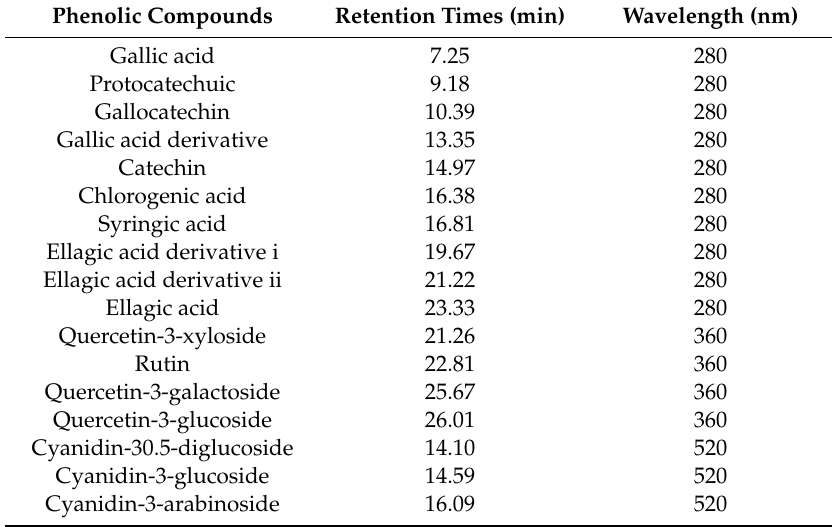
Table 6. Retention time and wavelength of phenolic compounds at Lambda 280 nm, Lambda 360 nm, and Lambda 520